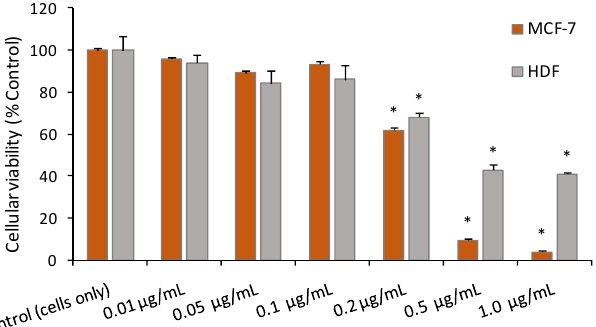
Figure 9. Cytotoxic activity of A. foeniculum EO against MCF-7 and HDF cell lines. The IC 50 values found using the GraphPad Prism software (vs. 5.0) were MCF-7, 0.24 ± 0.09 µ g/mL, and HDF, 0.47 ± 0.1 µ g/mL. Control = cells without treatment. Data are mean ± SD of two independent experiments with at least four replicates per condition. * Significantly different (Dunnett t -tests, 2-sided) from the basal conditions ( p < 0.001).